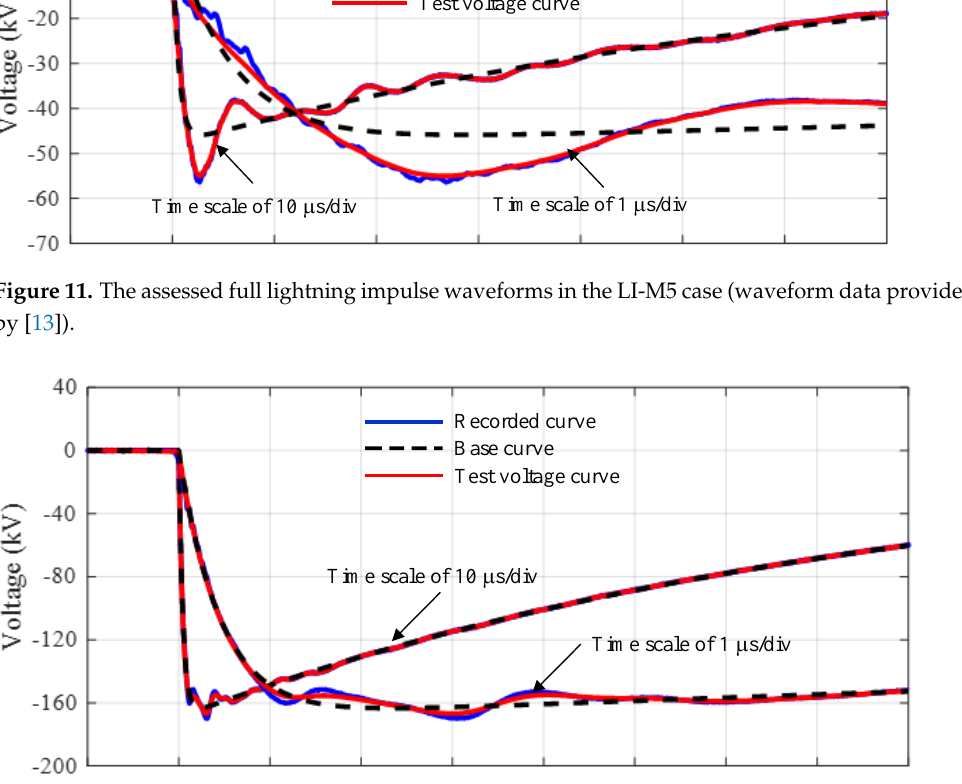
Figure 12. The assessed full lightning impulse waveforms in the LI-M6 case (waveform data provided by [13]).